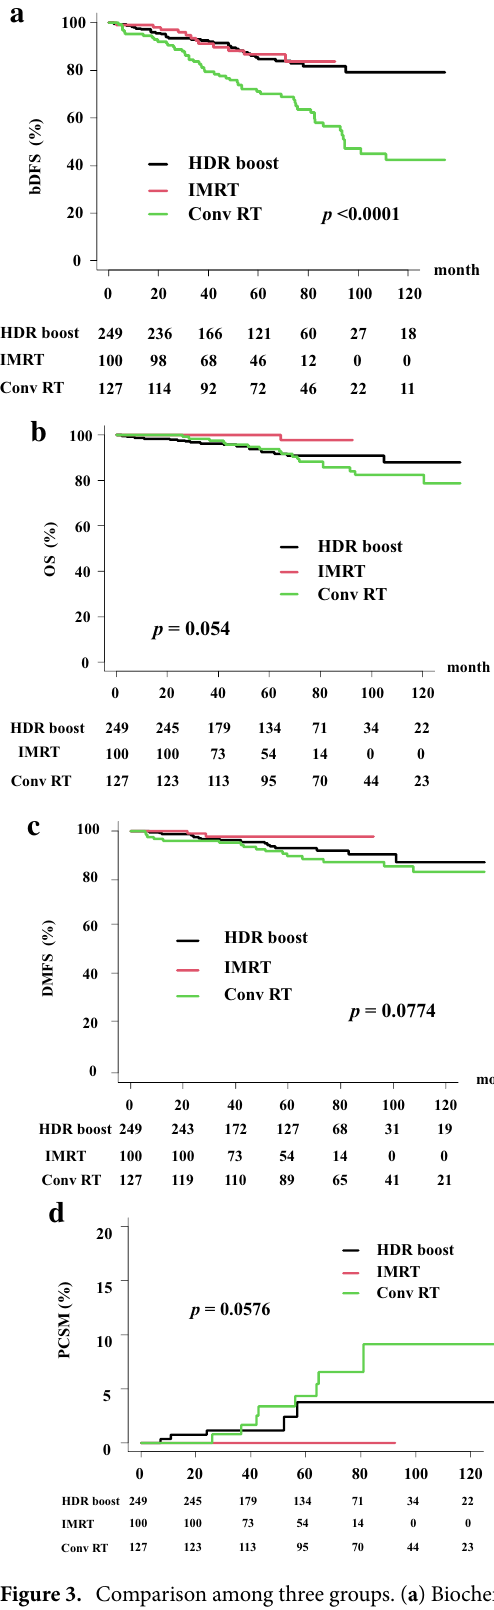
Figure 3. Comparison among three groups. ( a ) Biochemical disease-free survival (bDFS) among Conv RT, HDR boost and HD IMRT. ( b ) Overall survival rate (OS) among Conv RT, HDR boost and HD IMRT. ( c ) Distant metastasis free survival rate (DMFS) among Conv RT, HDR boost and HD IMRT. ( d ) Prostate cancer specific mortality (PCSM) among Conv RT, HDR boost and HD